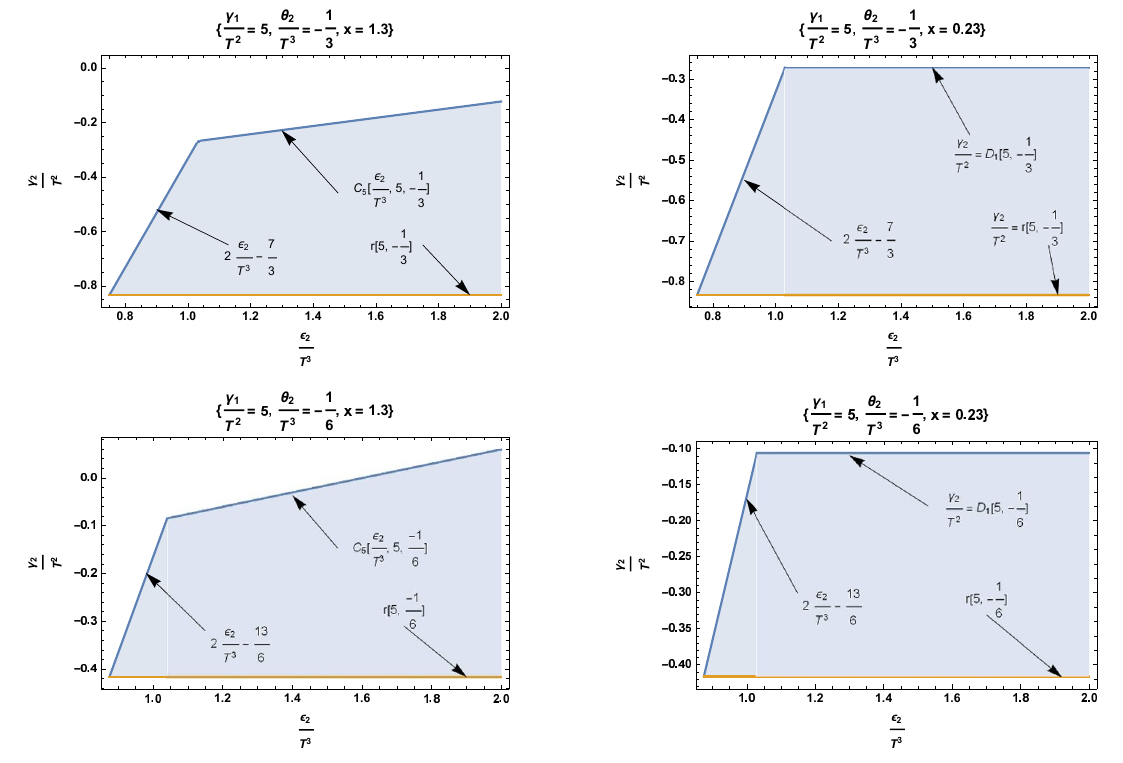
Figure 7 . Acceptable zones in the case of finite µ 0 and T 0 . Boundaries are given terms of table 1 data. From top-left to bottom-right figure the area of plot is 0.69, 0.61, 0.41 and 0.32, respectively. a decreasing pattern is seen. For the values ˜ ǫ 2 and ˜ θ 2 sitting on the boundaries of left part of figure 2, there is no acceptable